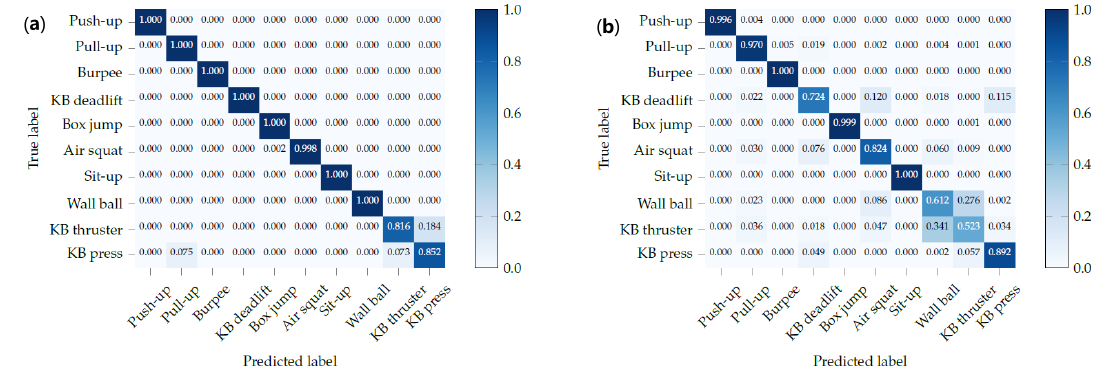
Figure 7. Comparison of recognition performance when only using the wrist or ankle watch respectively. ( a ) Confusion matrix of exercise recognition using only the sensors of the wrist watch. ( b ) Confusion matrix of exercise recognition using only the sensors of the ankle watch.